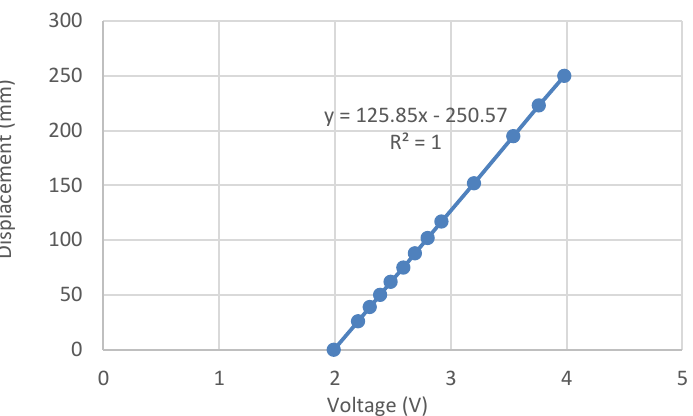
Figure 10. Displacement sensor calibration.